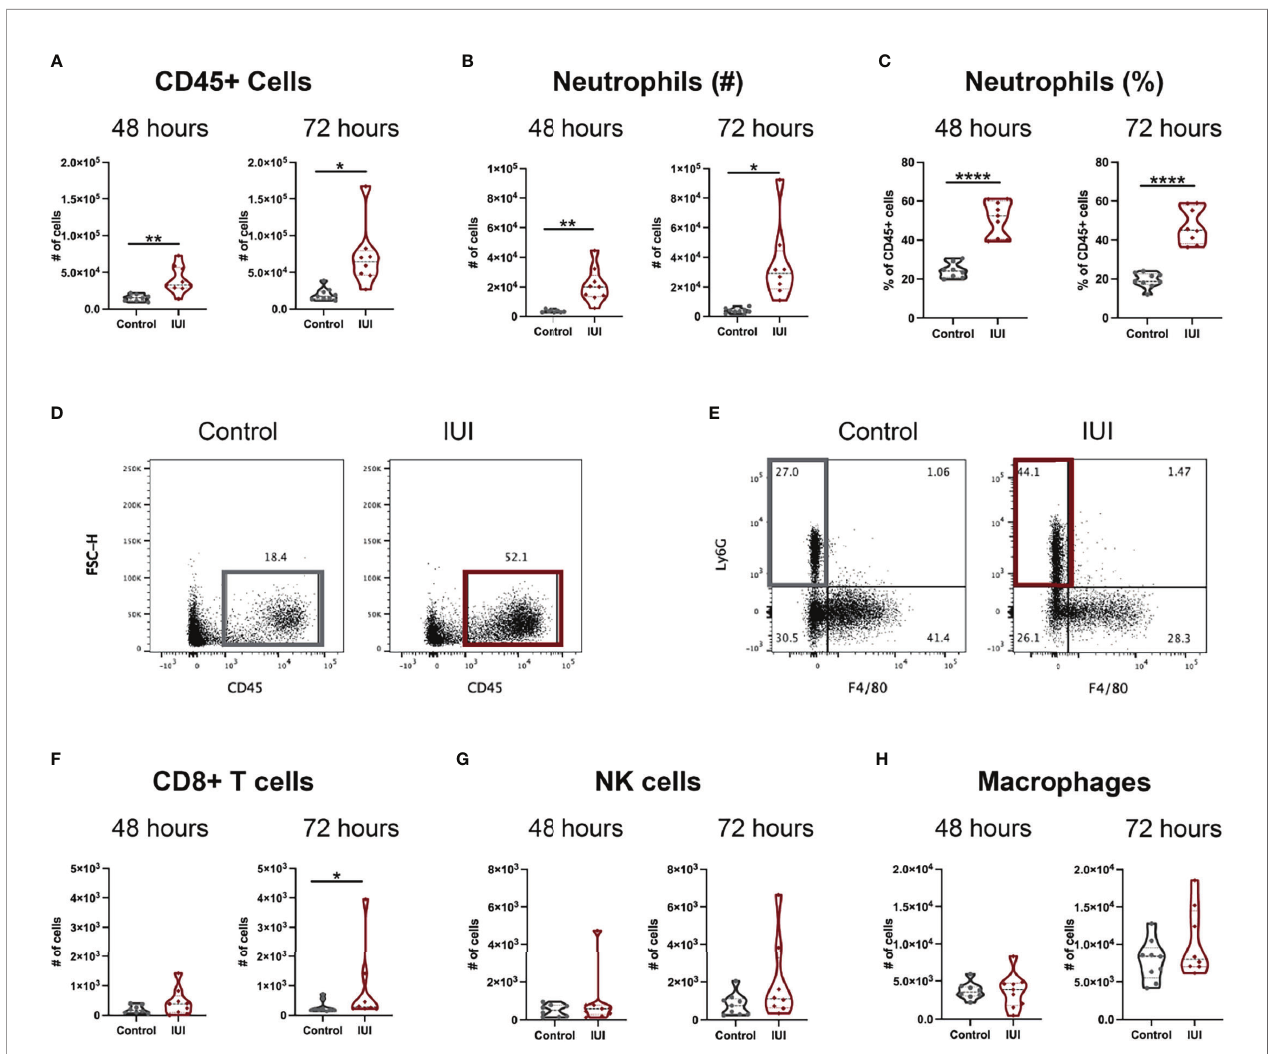
FIGURE 1 | Intrauterine in fl ammation causes sustained in fl ux of neutrophils to the decidua. Decidua was removed from the uterus at 48 and 72 hours post-uterine injection. All decidual cells were analyzed by fl ow cytometry to have full counts of (A) CD45+ cells. (D) Representative fl ow plots of total CD45+ cells are gated on non-debris, singlet, live cells. Immune cell subsets were reported both as cell counts and as a percent of total CD45+ cells, including (B, C) neutrophils, (F) CD8+ T cells, (G) NK cells, and (H) macrophages. (E) Representative fl ow plots of neutrophils were gated on non-debris, singlet, live, CD45+, CD19-, CD4-, CD8- cells. Signi fi cance was determined by unpaired t-test with Welch ’ s correction if positive F-test. *p<0.05, **p<0.01,